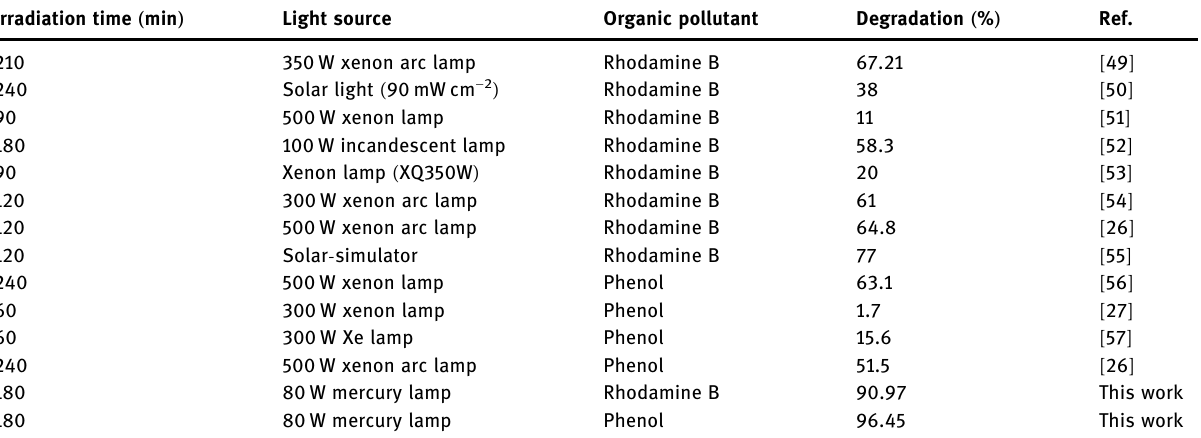
Table 1: Rhodamine B and phenol photodegradation by SnS nanoparticles Irradiation time ( min